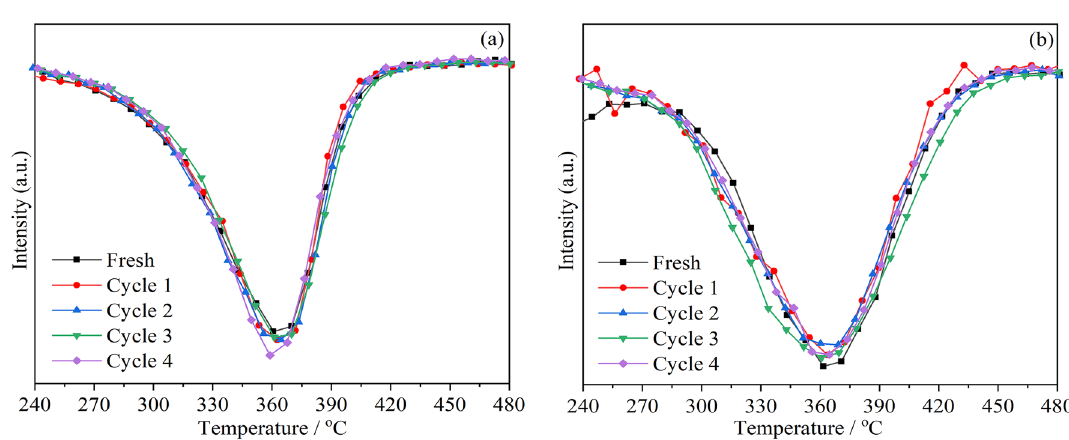
Figure 1. Soot catalytic activities of the catalysts: ( a ) DTG curves; ( b ) DSC curves. (under the tight contact condition).